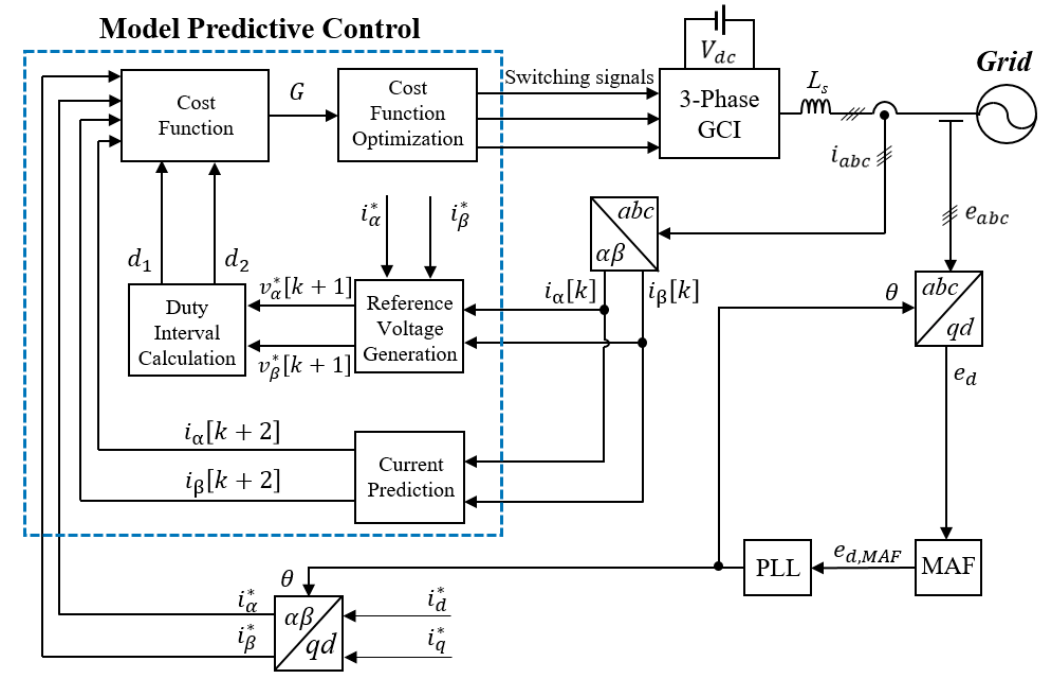
Figure 2. Block diagram of the proposed FCS-MPC.